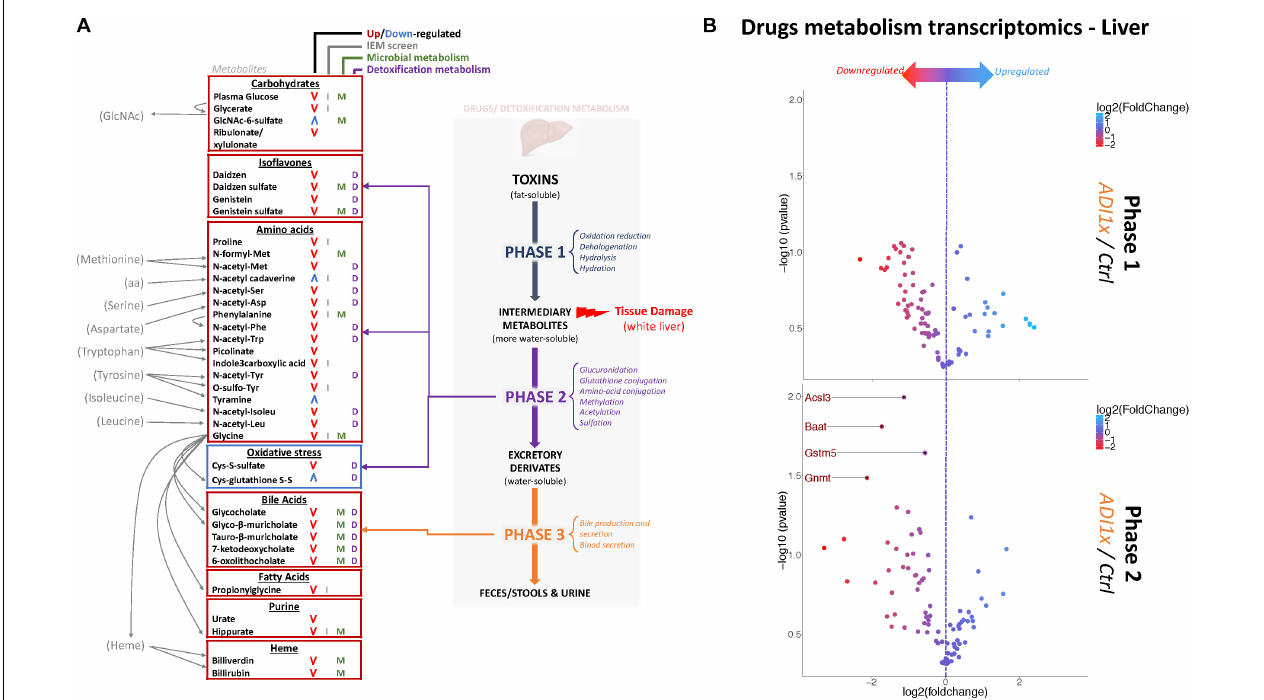
FIGURE 3 | Non-nutritive sweetener pups exhibit an imbalanced liver detoxification system. (A) A summary of highly deregulated metabolites and their interplay with detoxification/drug metabolism. IEM, Inborn Error of Metabolism (B) Volcano plots representing the fold change in mRNA levels of phase 1 (Top panel) and phase 2 (Bottom panel) metabolic enzymes from livers of 20-day old control and ADI1x pups are shown. Labeled genes are significantly deregulated in ADI1x vs. control pups ( p < = 0.05) ( t -test).